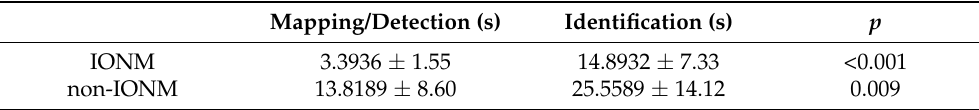
Figure 3. ( A ) Comparison of RLN mapping/detection time and ( B ) identification time between IONM and non-IONM groups. Table 2. Comparison of mapping/detection and identification times of the RLN † between IONM * and non-IONM *